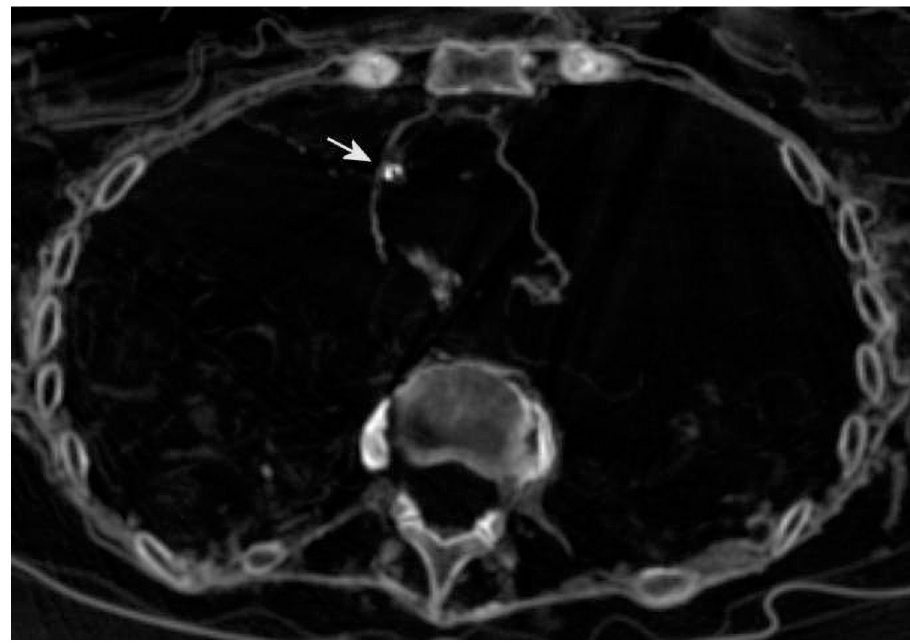
Fig 8. CT scan of the heart showing focal ring-like calcification of one of the coronary vessels (arrow).